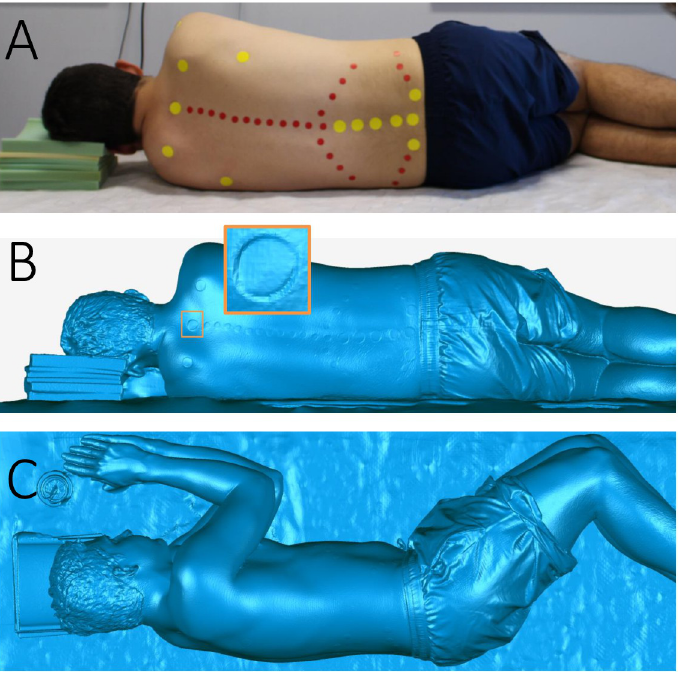
with red and yellow stickers. (A) Participants were guided in assuming a posture with the shoulders and hips vertically aligned. (B) The coronal plane of the 3DSS reconstruction is viewed perpendicularly to the substrate surface, with a magnified view of the C7 marker. (C) The sagittal plane is viewed parallel to the substrate surface, oriented such that the line between the origin and L1 marker is